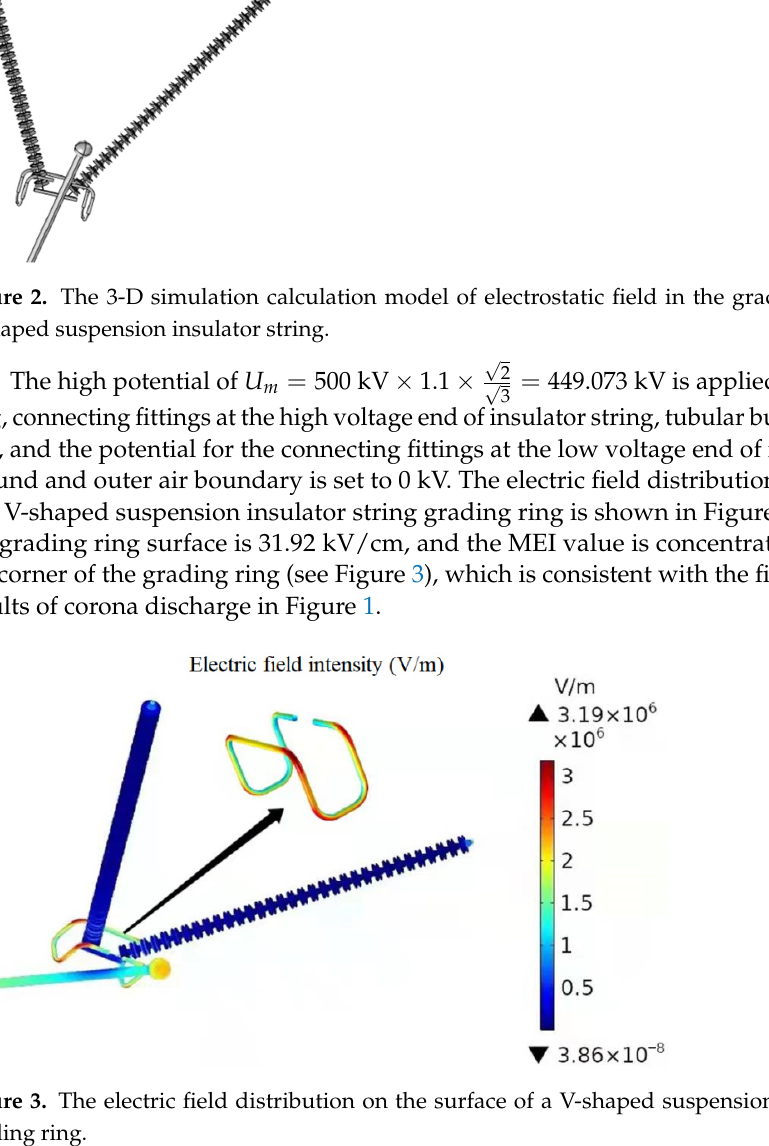
Figure 3. The electric field distribution on the surface of a V-shaped suspension insulator string grading ring.